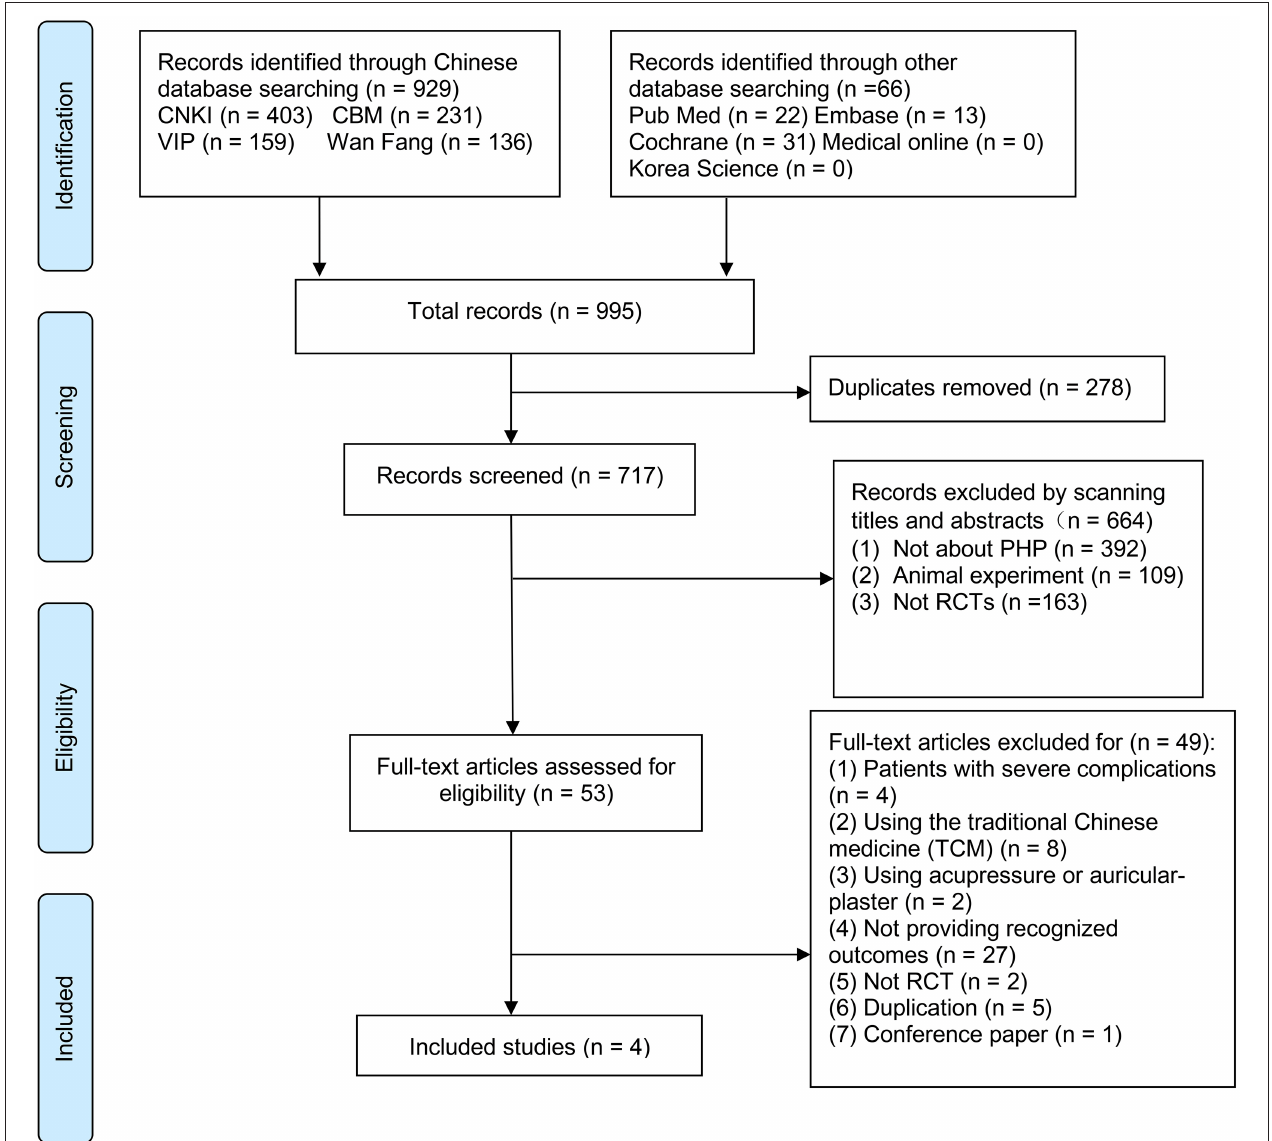
FIGURE 1 | PRISMA flow diagram of Selection of studies process. PRISMA, Preferred reporting items for systematic reviews and meta-analyses; RCT, randomized controlled trials.